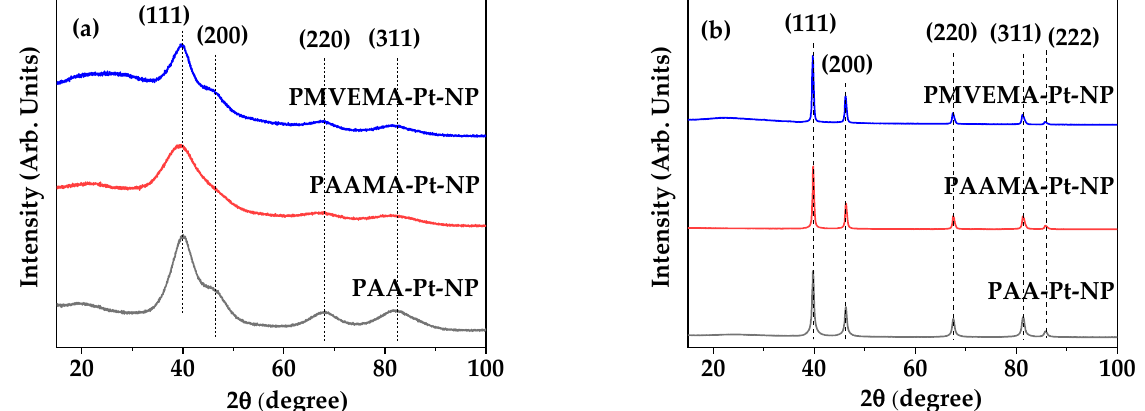
Pt-NP samples, confirming successful polymer coating on the Pt-NP surfaces (Figure 5a–c). The observed absorption frequencies are listed in Table 2. The C=O symmetric stretch at ~1695 cm − 1 was reduced in intensity and was also red-shifted and split into symmetric and antisymmetric stretches of COO − after coating; these could be attributed to the electrostatic bonding between COO − groups of the polymers and Pt atoms on the NP surfaces [49,50]. This corresponds to a hard acid (Pt atoms on the NP surfaces) hard base (COO − groups of the polymers) type of bonding [51], as depicted in Figure 5d. Owing to the numerous COO − groups per polymer, multiple bonds can exist between many COO − groups of a polymer and many Pt atoms on a Pt-NP